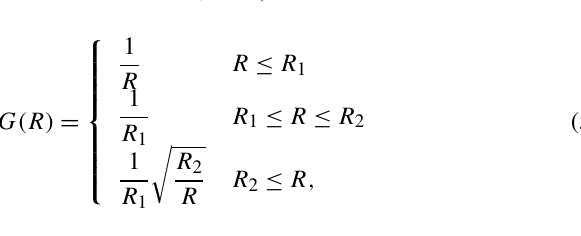
Atkinson and Boore, 1995).